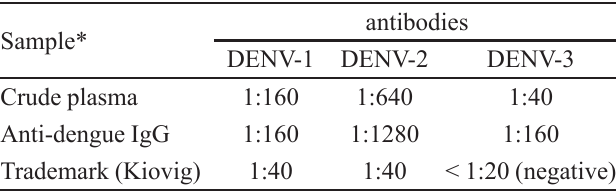
TABLE II - Dengue antibody titers of the specific immunoglobulin preparation by plaque